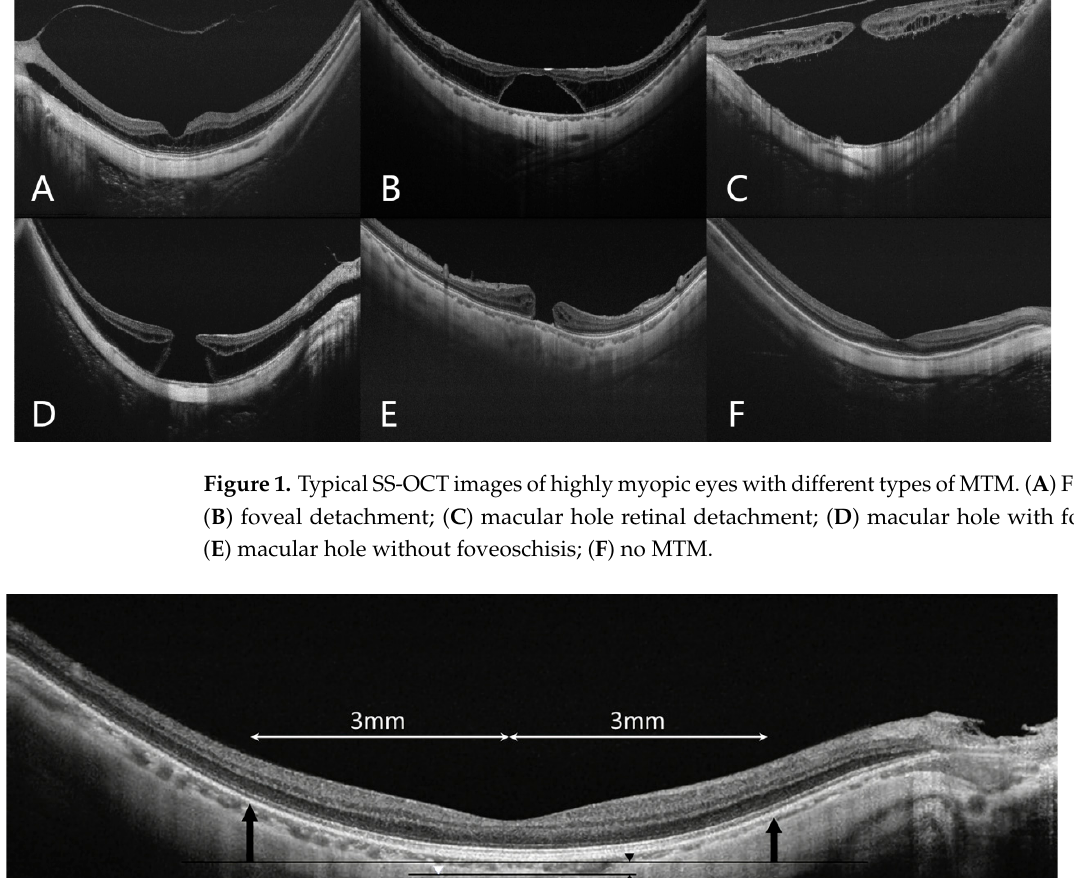
Figure 1. Typical SS-OCT images of highly myopic eyes with different types of MTM. ( A ) Fove- oschisis; ( B ) foveal detachment; ( C ) macular hole retinal detachment; ( D ) macular hole with fove- oschisis; ( E ) macular hole without foveoschisis; ( F ) no MTM.